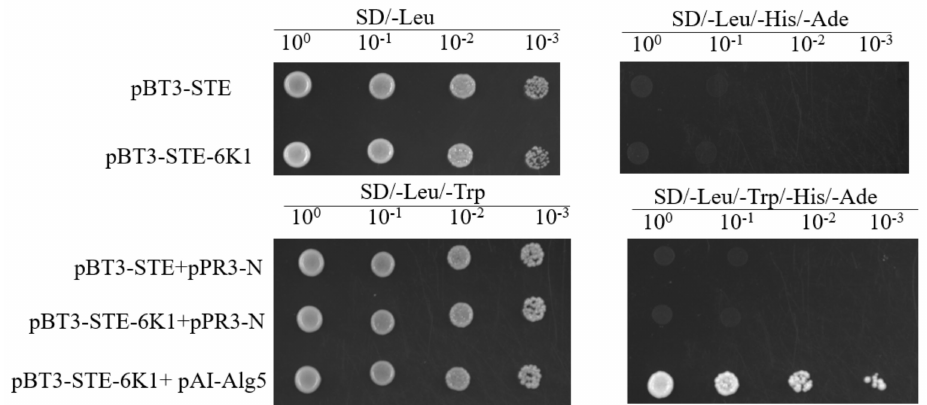
Figure 2. Evaluation of the pBT3-STE-6K1 bait vector. Yeast cells co-transformed with pBT3-STE-6K1 and pAI-Alg5 were use as the positive control, and pBT3-STE and pPR3-N were used as the negative control. The yeast grown cells were diluted by 1-, 10-, 100-, and 1000-fold.